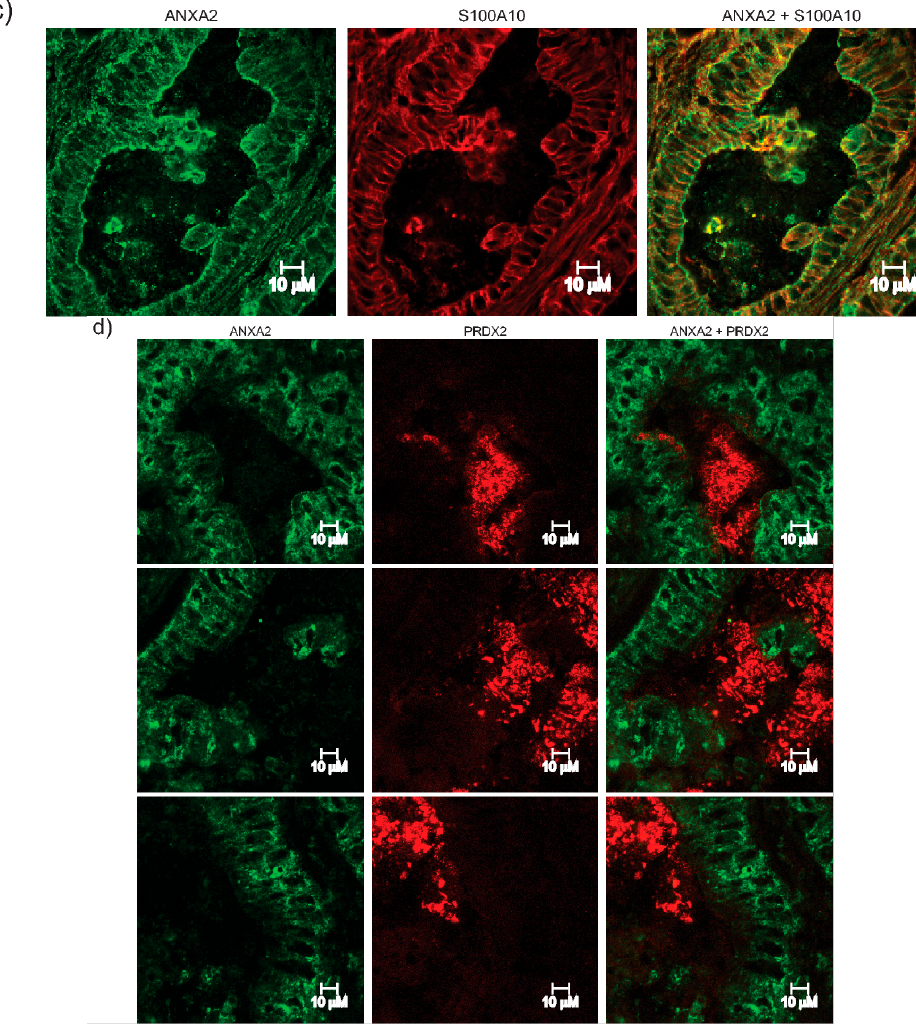
Figure 4. Western blot analysis of a panel of cell lines and clinical samples. ( a ) MCF7, 293T, A549, MiaPaca2, MDA-MB-231, HT1080, HCT116, HEK 293, TIME or U251 cells were lysed and 20 µg of each protein extract was subjected to SDS-PAGE, transferred onto nitrocellulose membranes and analyzed by western blotting with the antibodies indicated. This is a representative experiment of n > 3; Colon tumor clinical samples were flash frozen and sectioned using a cryostat. ( b ) Sections were then H&E stained or ( c , d ) fixed with methanol and immunostained with the antibodies indicated, followed by immunofluorescence staining with secondary antibodies (ANXA2-green; S100A10-red; PRDX2-red).